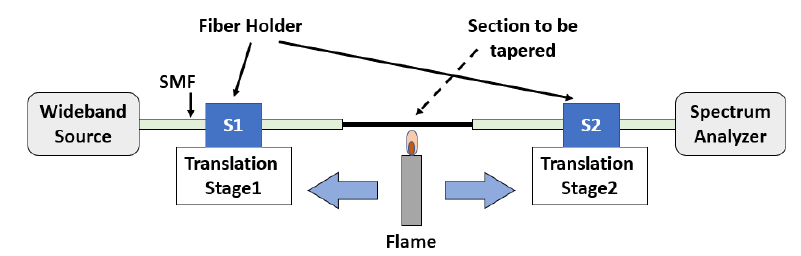
Figure 6. Schematic: flame brushing